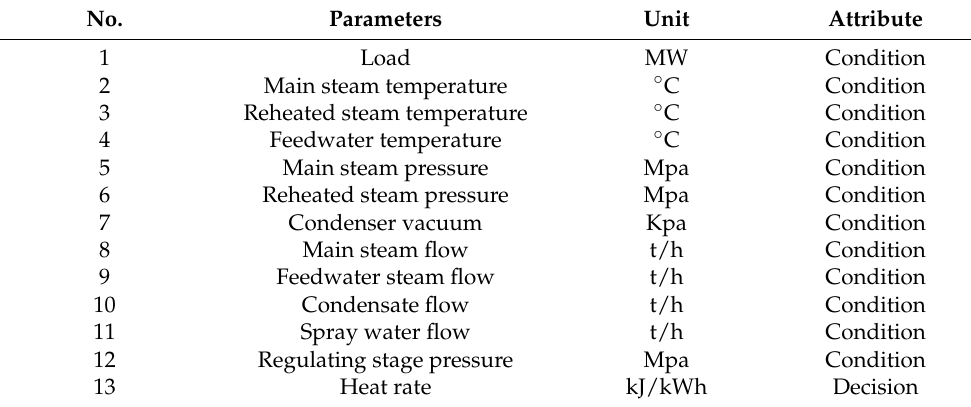
Table 3. Characteristic parameters of energy